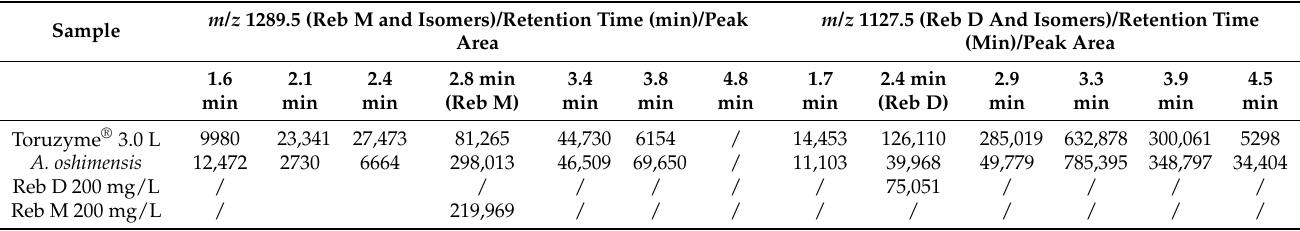
Table 1. Results of UPLC-ESI-MS detection of glucosylated steviol glycosides.